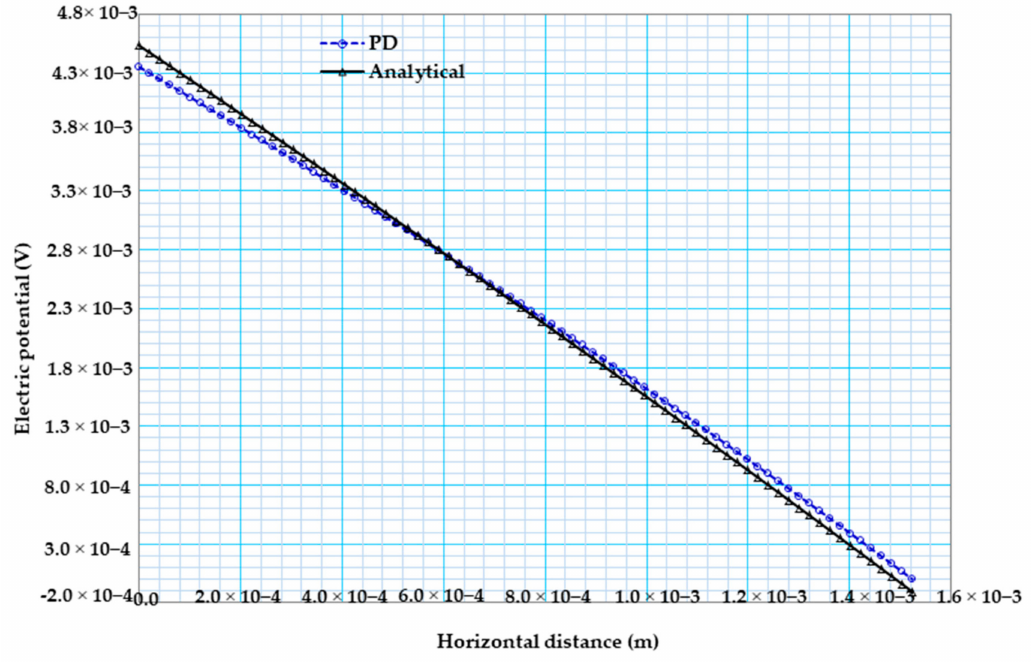
Figure 10. 2D electric potential variations from PD and analytical solutions for temperature-dependent material